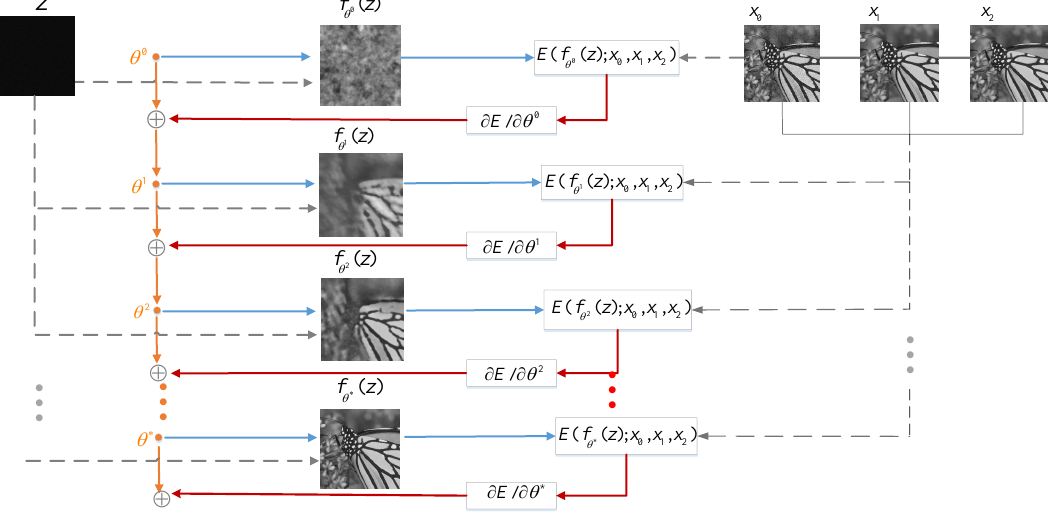
Figure 4. Image denoising uses our generative network.